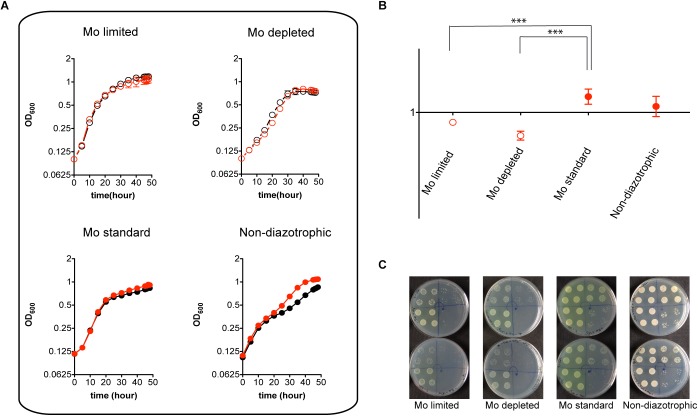
Diazotrophic growth and CI analysis of the MoSto mutant. (A)
A. vinelandii DJ (wild type; black symbols) and UW394 (ΔmosAB, red symbols) were cultured in Burk’s modified N-free medium supplemented (close symbols) or not supplemented (open symbols) with 1 μM molybdate. Mo-limited (4 nM), Mo-depleted and Mo standard (1 μM) conditions were tested. All N-free media contained 1 μM vanadate. Growth in Burk’s modified medium containing ammonium acetate (non-diazotrophic) was carried out as control. (B) CI values were obtained from mixed cultures (1:1 inoculum ratio) of DJ and UW394 strains. Data represent the mean and standard deviation of three or four independent experiments. ∗∗∗ Indicates unpaired t-test P-value < 0.001. (C) Plates showing growth on solid media of mixed cultures that were pre-grown in liquid medium for 22 h. Four 20-μl drops with different dilutions (103, 104, 105, and 106) of the mixed culture were plated on each quarter of the plate. Arrows show the direction of the dilutions. Upper plates contain media lacking spectinomycin (to allow DJ and UW394 growth) whereas lower plates contain media supplemented with spectinomycin (to only allow UW394 growth).